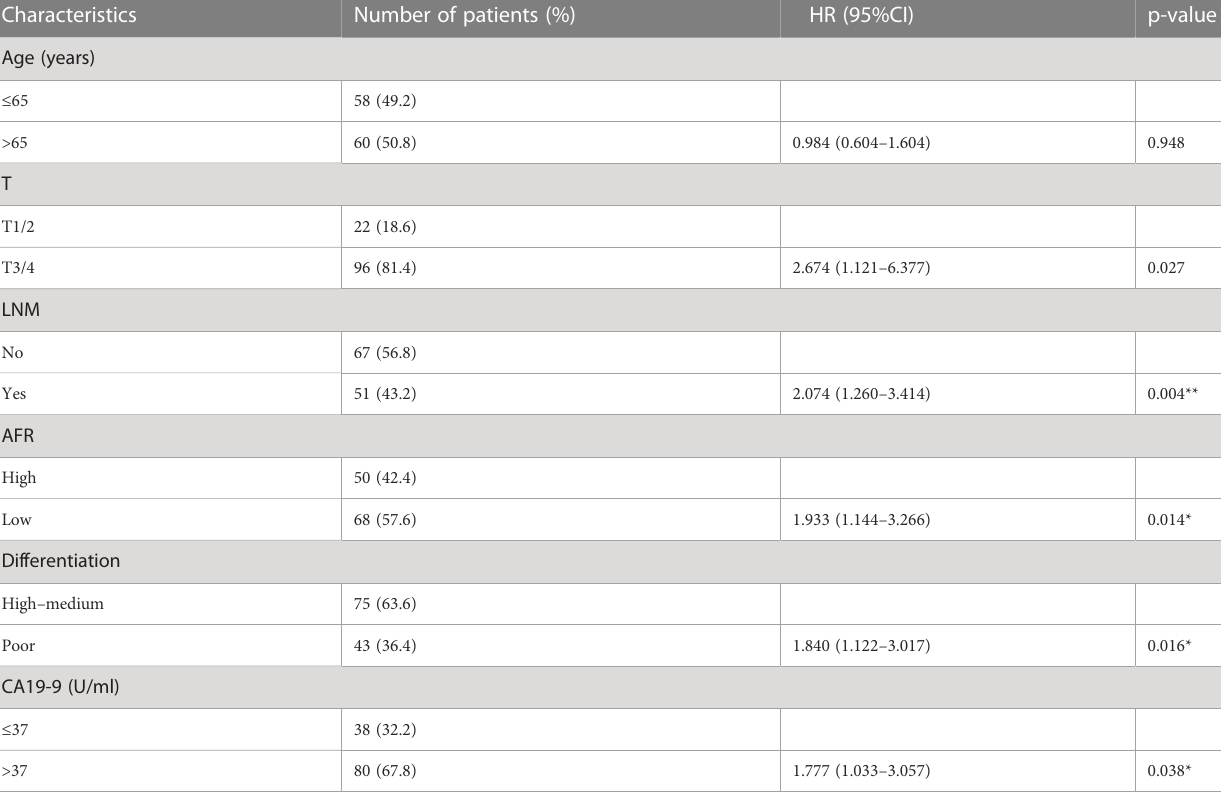
TABLE 3 Multivariate Cox regression analyses for predicting OS of patients with dCCA in the training cohort.